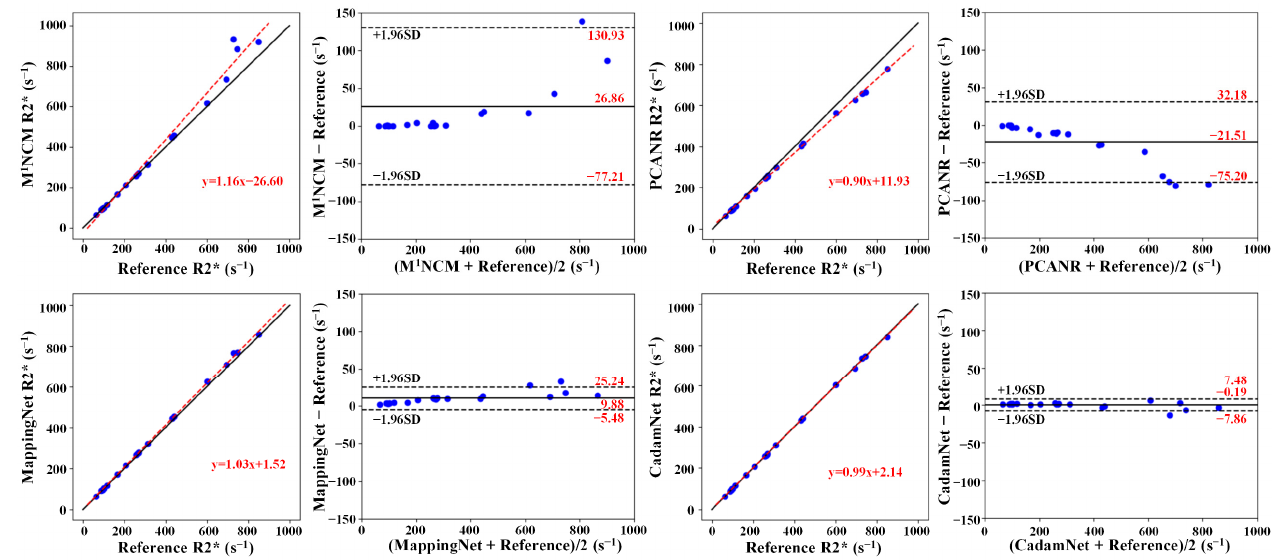
Figure 7. Scatterplots and Bland–Altman plots for the agreement of the mean R2* values in liver parenchyma (excluding vasculature) between the reference and the R2* maps reconstructed from different methods. The blue dots denote the subjects in the simulated testing liver dataset ( σ g = 17). The solid lines represent mean differences, and the dashed lines indicate 95% confidence intervals in Bland–Altman plots.